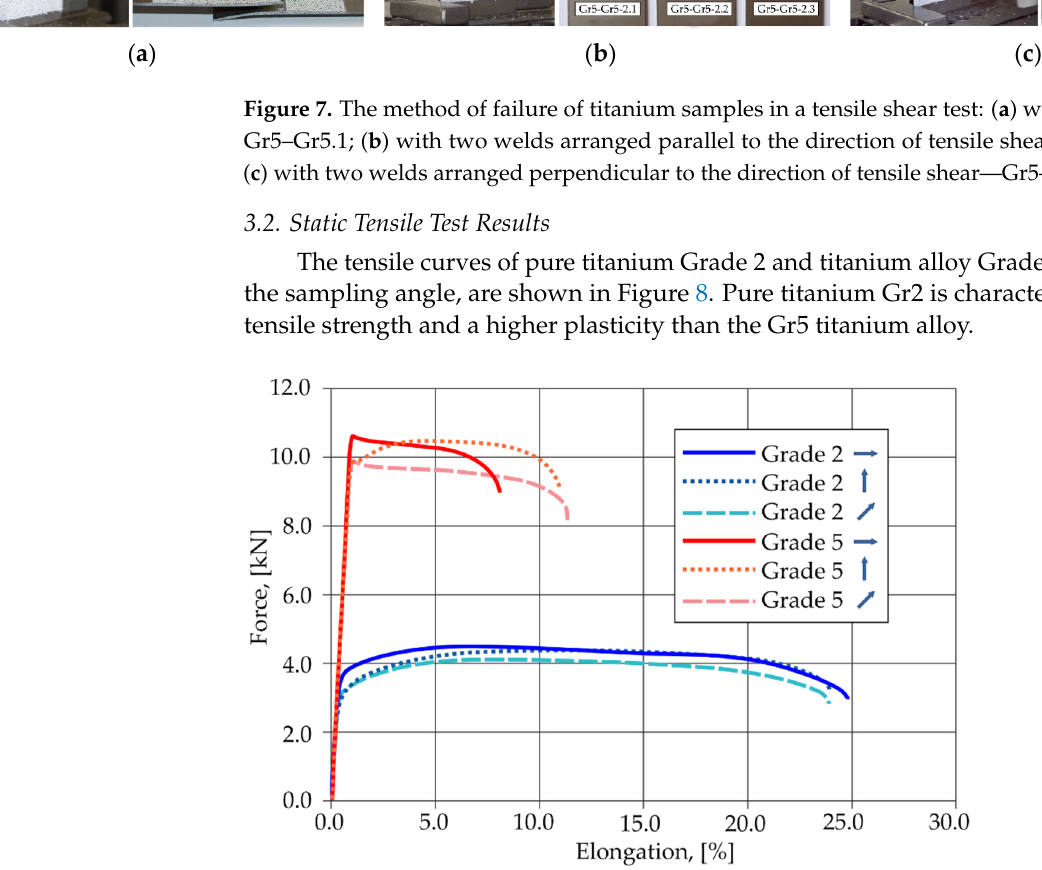
Figure 8. Tensile curves of Gr2 titanium and Gr5 titanium alloy, depending on the sampling angle. The hardening curves for the selected titanium samples are presented in Figure 9.